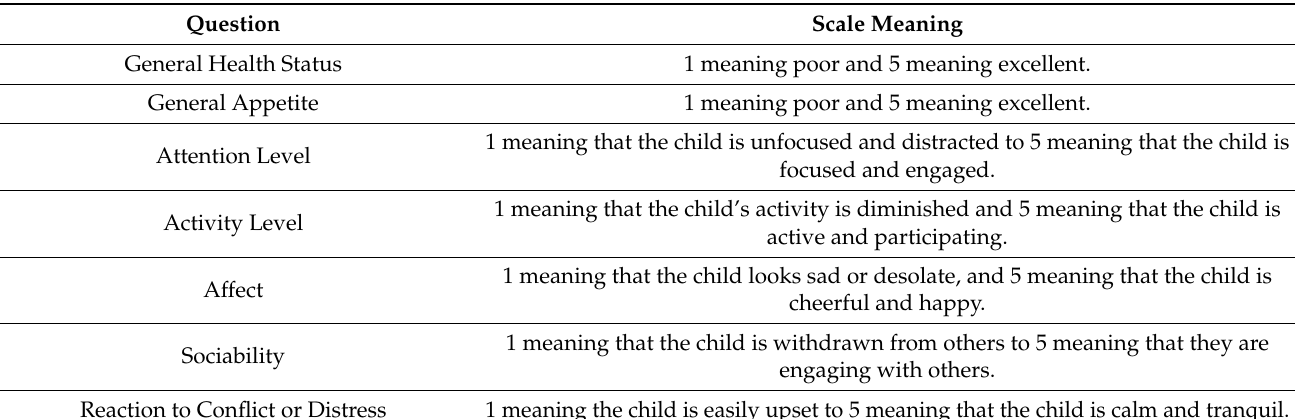
Table A1. Likert scale questions and answers for children. Measured responses to each question completed on day one and day